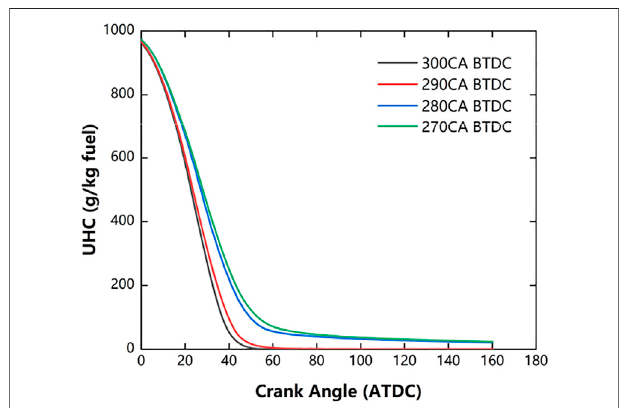
FIGURE 15 | Effect of injection timing on soot generation at several CAD in combustion duration.